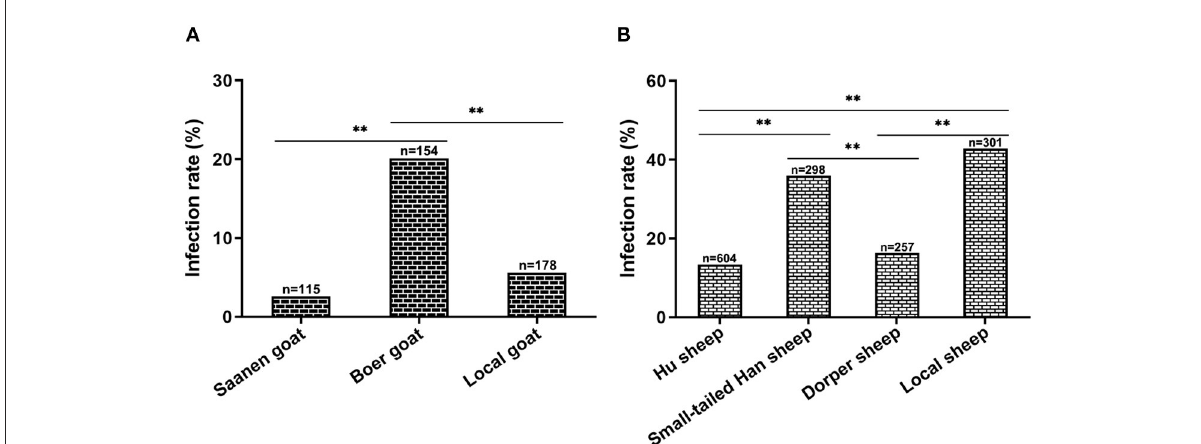
FIGURE4 Influence of goat/sheep breed on CEV/OEV infection. (A) Effect of goat breed on CEV infection. CEV infection rates of different breeds were comparatively analyzed. The CEV infection rate of Boer goats was much higher than that of Saanen goats and local goats ( p < 0.01), while there was no significant difference between Saanen goats and local goats ( P > 0.05). (B) Influence of sheep breed on OEV infection. OEV infection rates of small-tailed Han sheep and local sheep were revealed significantly higher than those of Hu sheep and Dorper sheep ( p < 0.01), while no significant differences were observed between small-tailed Han sheep and local sheep ( P > 0.05), as well as Hu sheep and Dorper sheep ( P > 0.05). “n” represents the number of specimens detected. **Indicates highly significant difference ( P < 0.01).